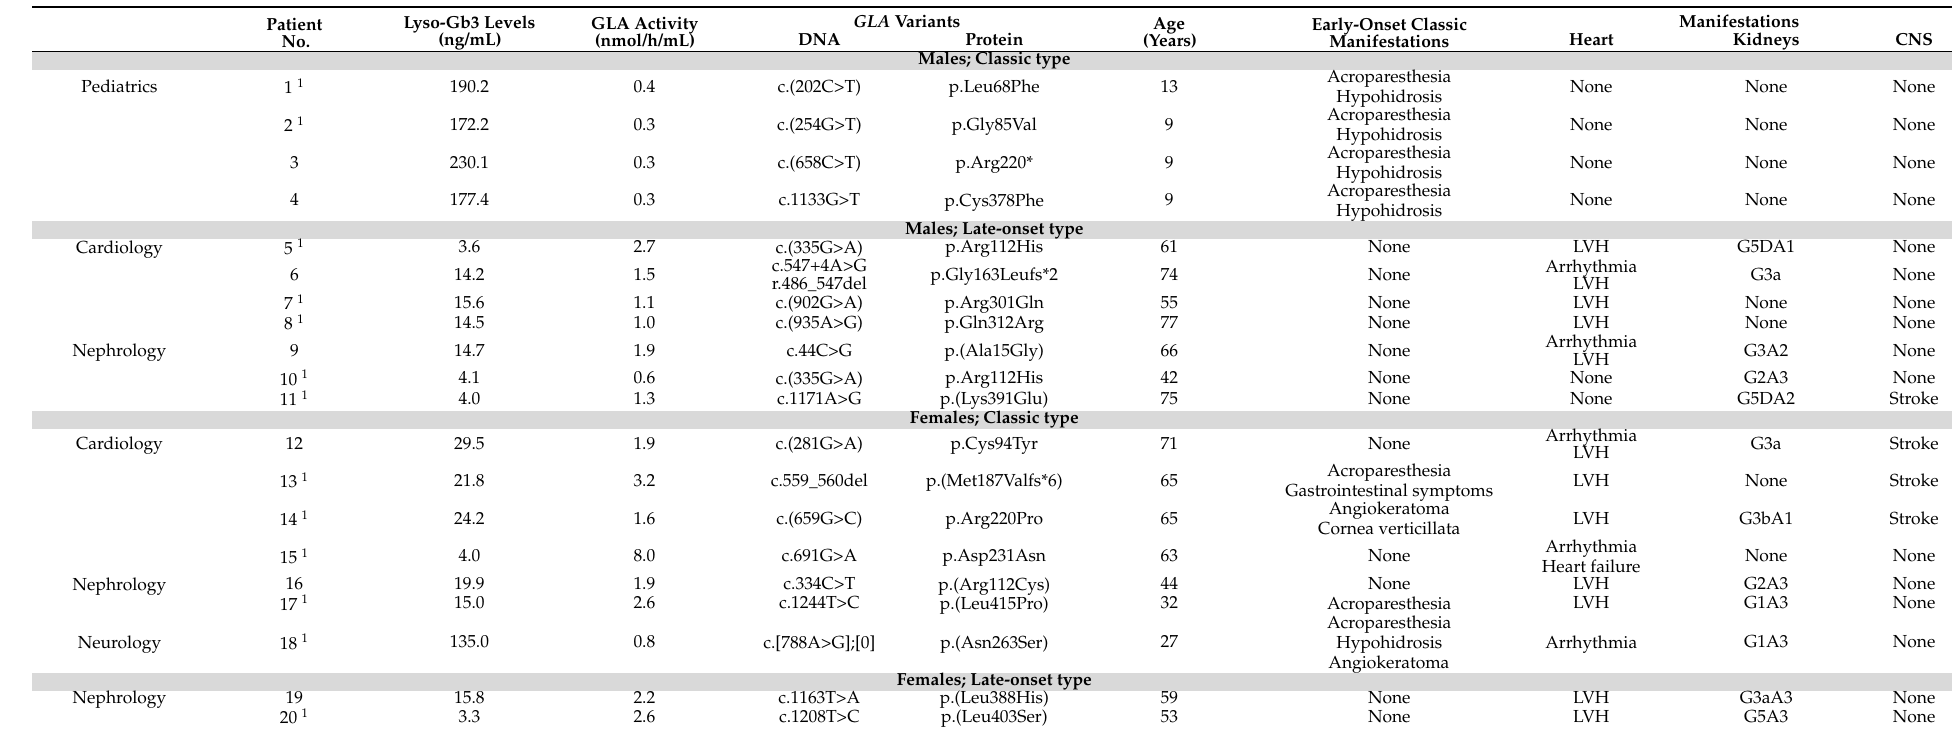
Table 2. Characterization of patients with Fabry